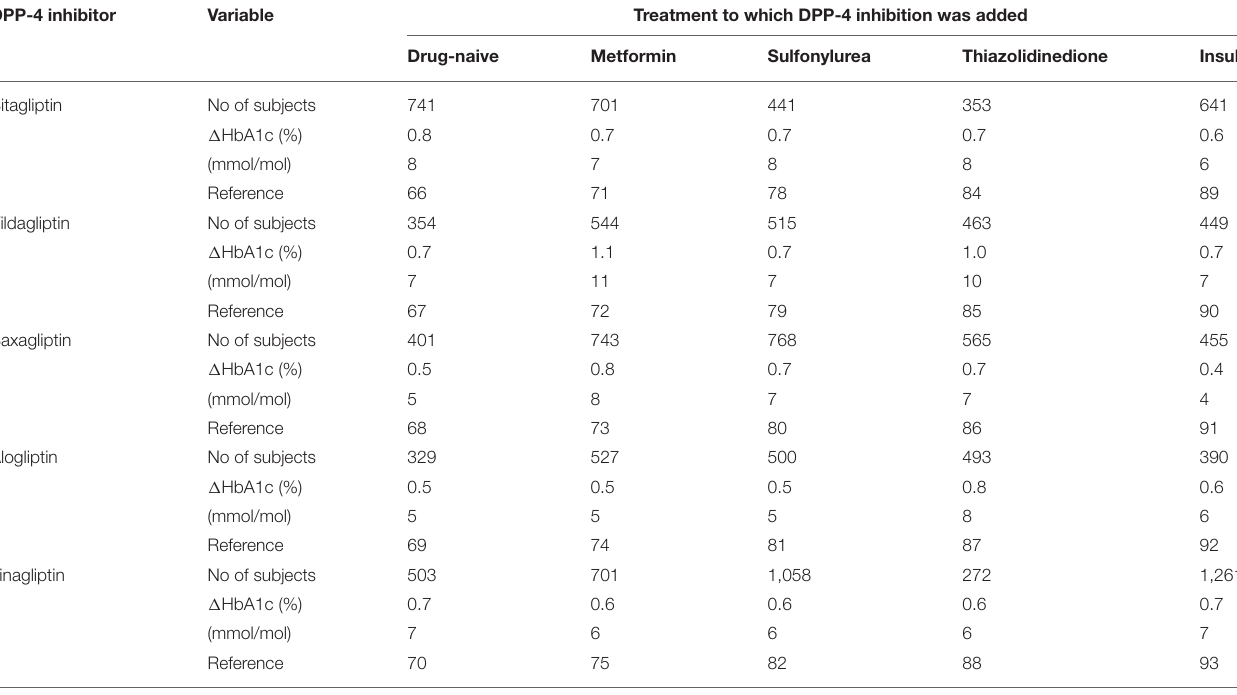
TABLE 2 | Development studies with five DPP-4 inhibitors: number of examined subjects and placebo-adjusted change in HA1c when DPP-4 inhibitors were added to drug-naïve subjects with type 2 diabetes or as add-on to metformin, sulfonylurea, thiazolidinediones, or insulin in placebo-controlled 24 or 26 week studies. DPP-4 inhibitor Variable Treatment to which DPP-4 inhibition was added Drug-naive Metformin Sulfonylurea Thiazolidinedione Insulin Sitagliptin